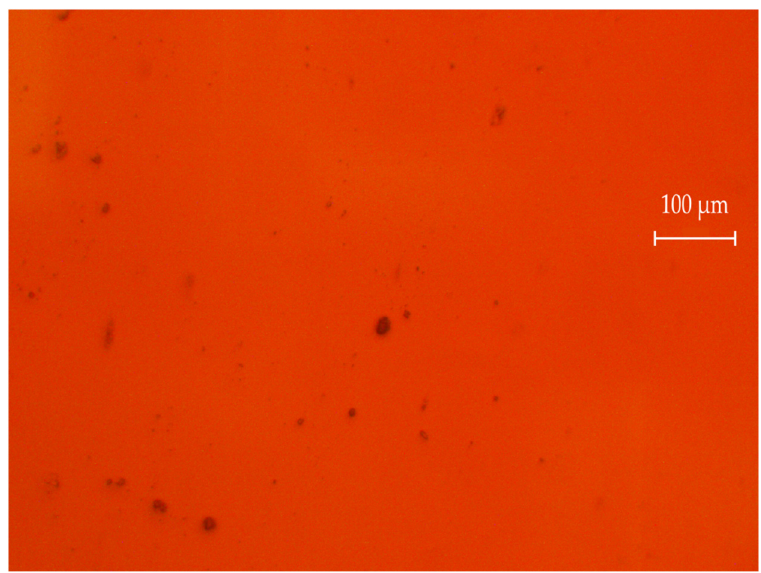
Figure 3. A typical micrograph of an optical image of specimen 2.2.